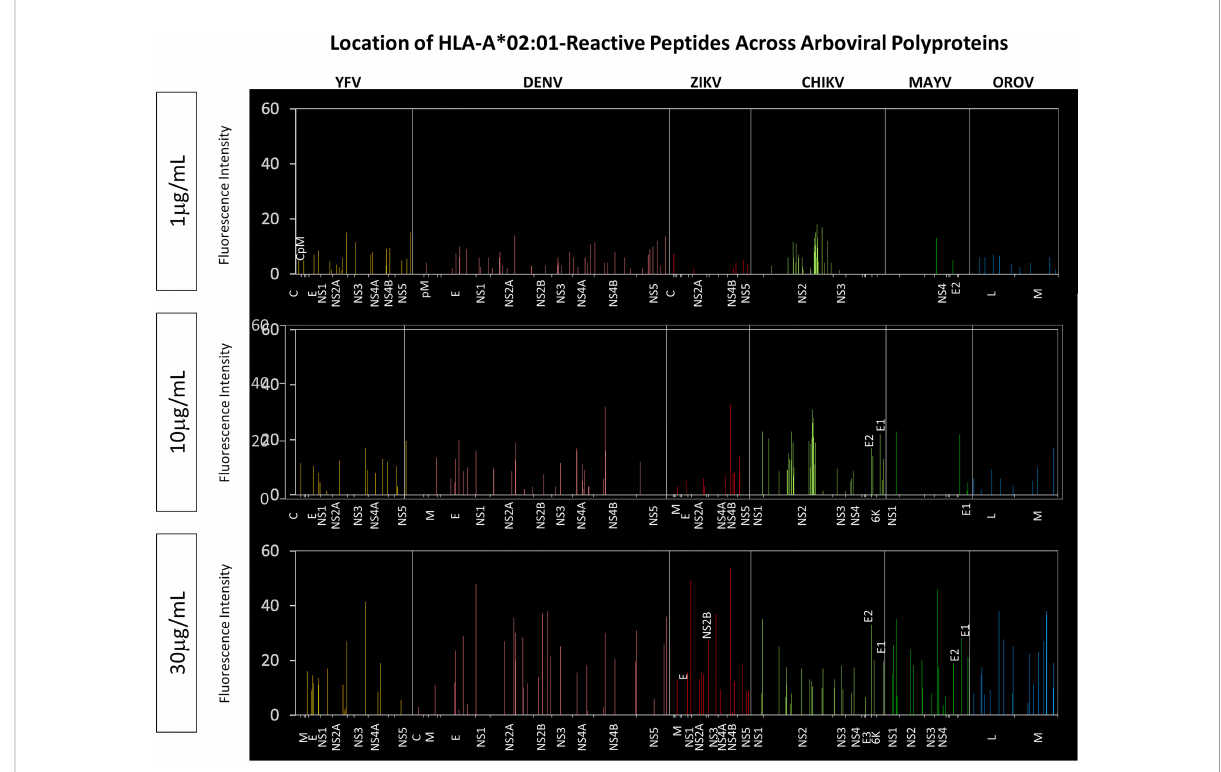
FIGURE 6 Location of HLA-A*02:01-Reactive Peptides Across Arboviral Polyproteins. Multiple alignment using MUSCLE algorithm was performed using HLA- A*02:01-reactive peptides and the respective arbovirus polyprotein. Reactive peptides from all three HLA-A*02:01 protein concentrations were assessed separately. Only regions with HLA-A*02:01-reactive peptides are identi fi ed on the x-axis of the graph for every arbovirus